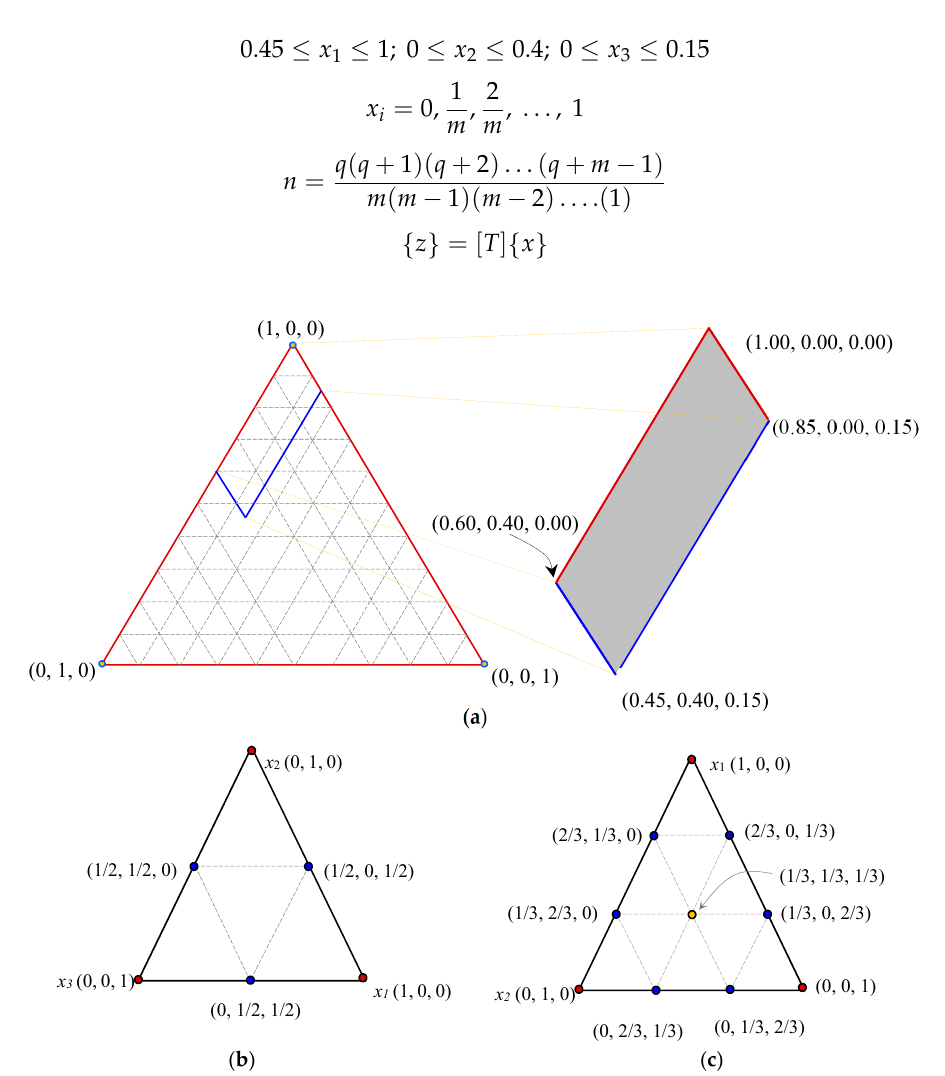
Figure 4. The simplex-lattice equilateral triangular and the corresponding pseudo-coordinates of a three-component mixture: ( a ) Entire lattice, ( b ) [3, 2] lattice and ( c ) [3, 3] lattice.